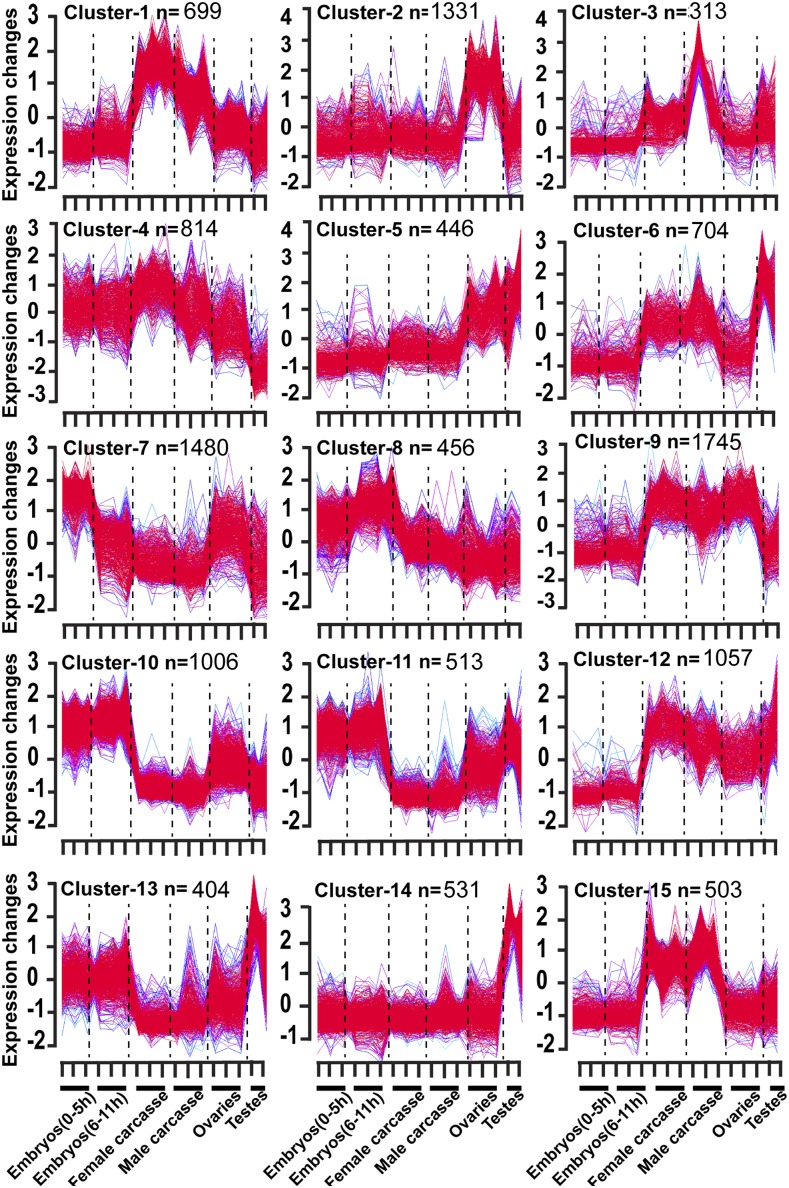
Stage specific changes in gene expression. Genes co-expressed in the Tribolium different embryo stages and tested tissues. The X-axis represents samples, samples 1-3 (embryo 0-5 hr), 4-6 (embryo 6-11 hr), 7-9 (female carcass), 10-12 (male carcass), 13-15 (ovary), and 16-17 (testis), with the Y-axis representing change in expression. Line color was assigned to each gene, with red (1) indicating high association in membership to the cluster. Purple, green or blue lines correspond to genes with lower membership values; “n” indicates number of genes assigned to each cluster.